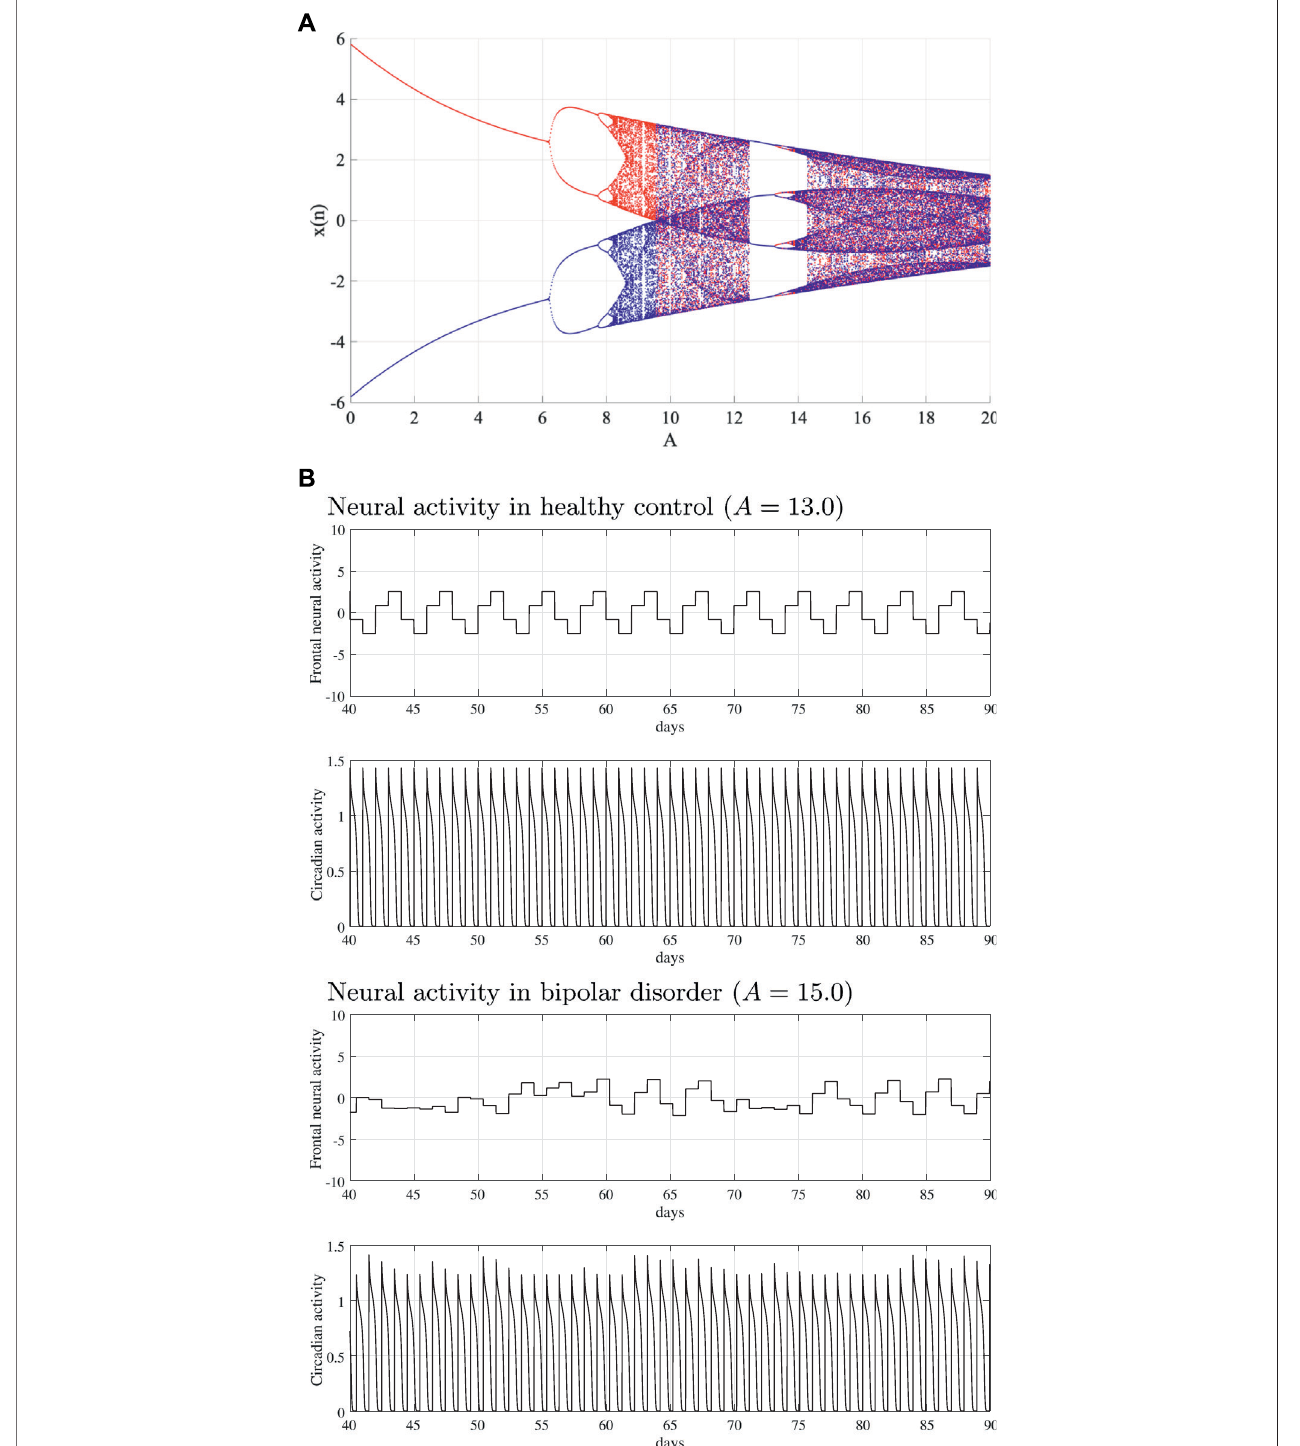
FIGURE 2 | System behaviors in the neural system composed of the frontal cortex and hypothalamus as a function of synaptic weight from the inhibitory neural population A . (A) Bifurcation diagram of the frontal neural activity x ( n ) given by Eq. (1) as a function of A . Blue and red dots indicate the positive and negative initial value x (0) cases, respectively. (B) Time-series of frontal neural activity x ( n ) and circadian rhythm output( k ) are given by Eq. (8) in healthy controls (upper panel) and bipolar disorder (lower panel) patients. In A a 9 . 8, x ( n ) goes back and forth between negative and positive regions, (chaos – chaos intermittency). The periodic window exists in 12 . 5 ( A ( 13 .